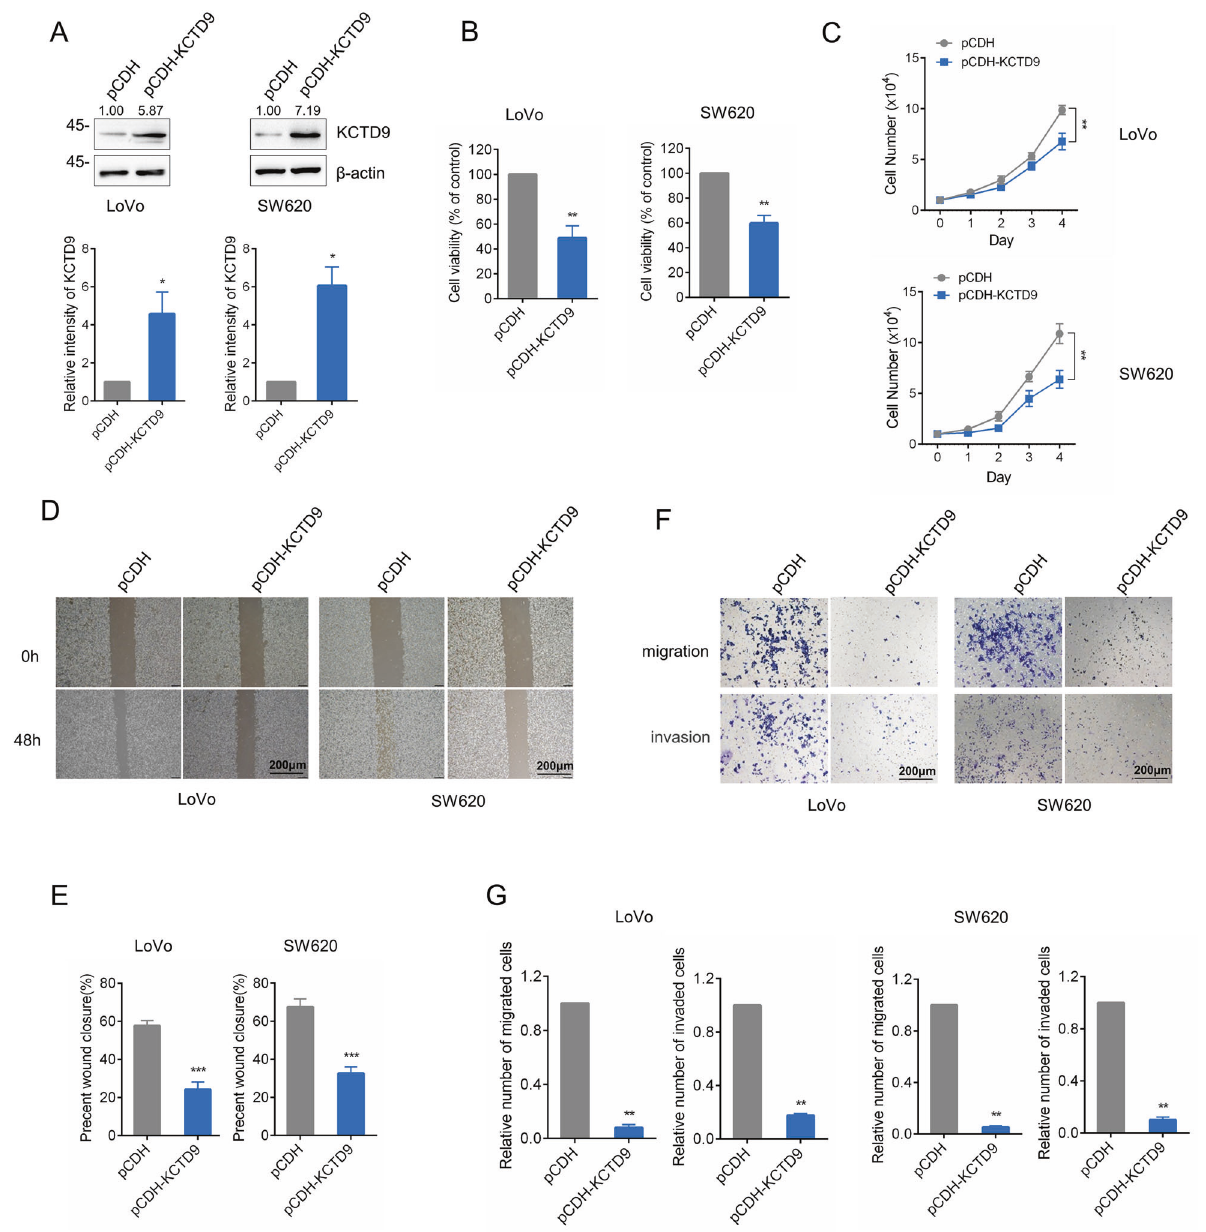
Fig. 3 KCTD9 inhibits CRC cell proliferation and metastasis in vitro. A Western blotting analysis of the CRC cell lines LoVo and SW620 after infection with lentiviral particles based on control pCDH or pCDH-KCTD9 vectors to overexpress KCTD9. β -actin was used as a loading control. Data shown represent three independent experiments (top) and relative density were quanti fi ed by using ImageJ software (bottom). B Assessment of cell viability in the cells from A measured using CCK-8 assays. C Assessment of proliferation in the cells from A measured using Count Star (Countstar BioTech) over 1 – 4 days by cell counting. D , E Assessment of migration in the cells from A measured in wound healing assays. Representative images at time 0 and 48 h (scale bar = 200 µm) ( D ) with quantitation of wound closure ( E ). D represent three independent experiments. F , G Assessment of migration and invasion in the cells from A using Transwell ™ assays. Representative images of migrating/invading cells after 24 h (scale bar = 200 µm) ( F ) with comparative quantitation of total migrating cells ( G ). F Represent three independent experiments. A , B , E , G Are mean ± SD, n = 3 independent experiments, two-tailed Student ’ s t test, * p < 0.05, ** p < 0.01, *** p < 0.001. C is mean ± SD, n = 3 independent experiments, two-way ANOVA with Bonferroni ’ s multiple comparison post-test, ** p <